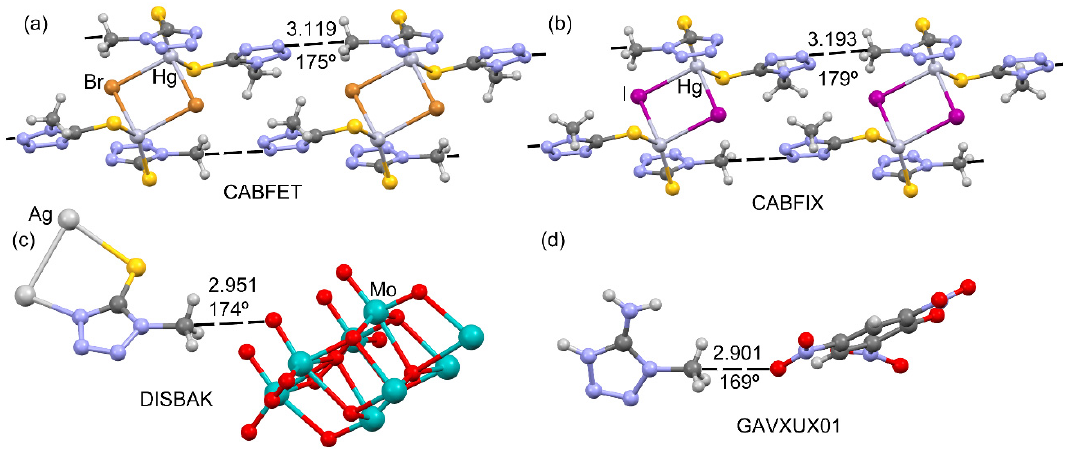
Figure 7. X-ray structures of CSD refcodes. ( a ) CABFET; ( b ) CABFIX; ( c ) DISBAK; ( d ) GAVXUX01. Distances in Å are given adjacent to the dashed lines used to represent the TtBs.